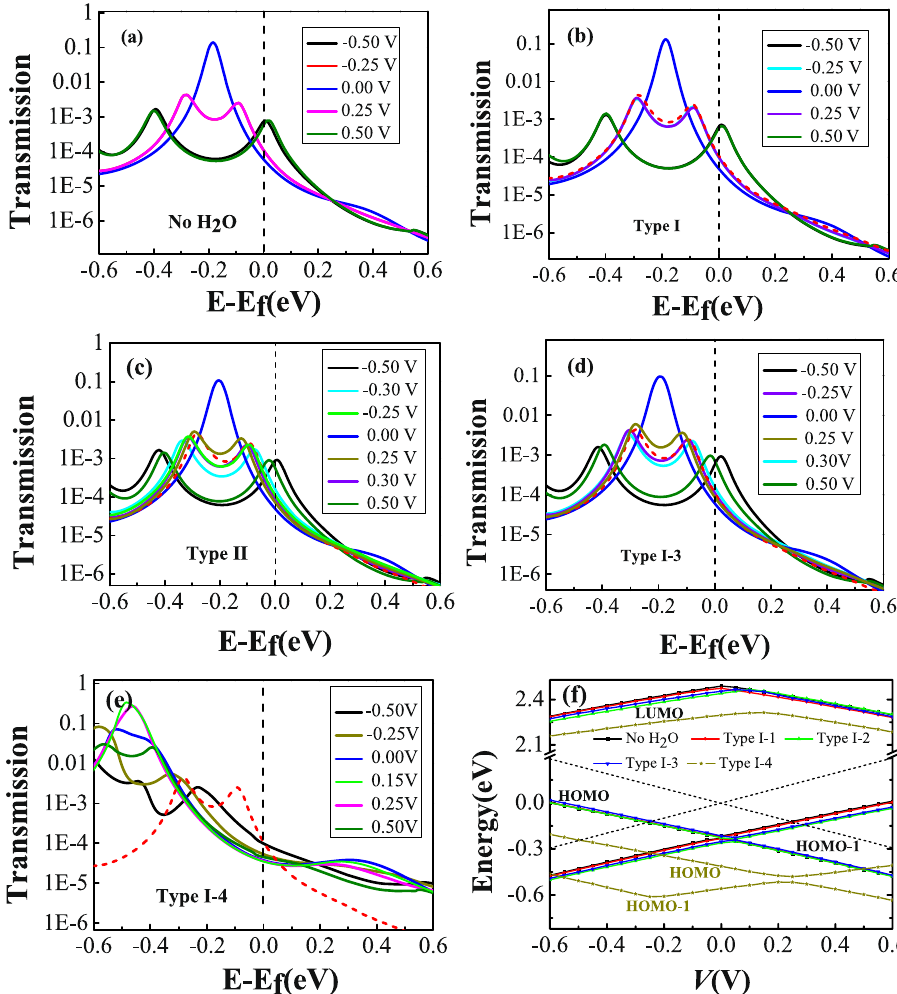
Figure 3. Transmission spectra and evolutions of the frontier molecular orbitals of TADHA molecular junctions. ( a ) Transmission spectra of TADHA molecular junction without H 2 O adsorbate; ( b ), ( c ), ( d ) and ( e ) Transmission spectra of TADHA molecular junction with one H 2 O adsorbate as Type I-1, 2, 3 and 4 molecular systems that are shown in Fig. 1. The red dashed lines in ( b ), ( c ) ( d ) and ( e ) are the transmission spectra of TADHA molecular junction without H 2 O adsorbate at 0.25 V bias voltage, which are used as reference curves in these four figures. ( f ) The energy of LUMO, HOMO and HOMO-1 as functions of bias voltage with one or without H 2 O adsorbate, the dashed line in ( f ) denotes bias